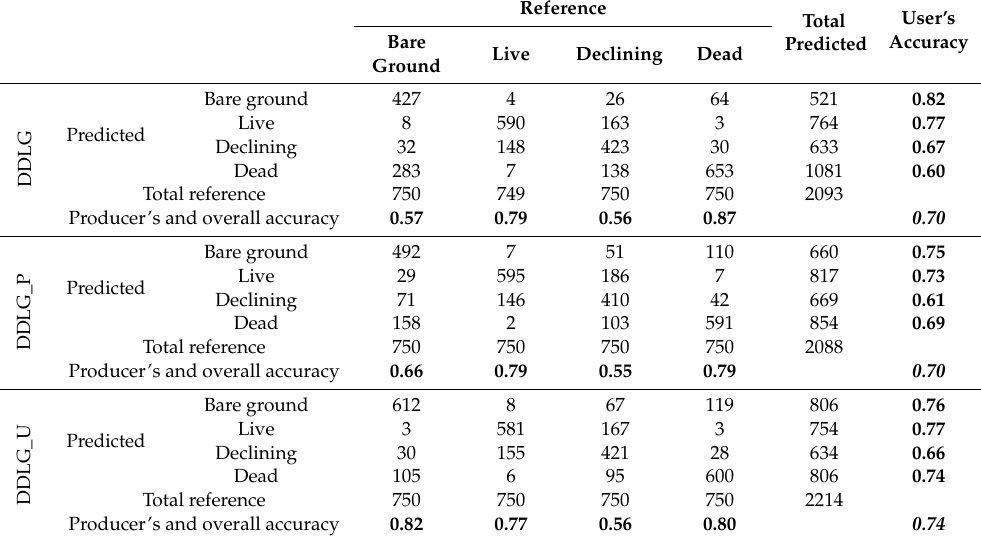
Table A3. Results of the validation of the three deadwood classification models Random Forest (RF) classification (DDLG), RF classification with post-processing (DDLG_P), and after applying a deadwood-uncertainty filter (DDLG_U) based on a stratified random sample (750 pixels per class). Results are presented as confusion matrix, user’s and producer’s accuracy are in bold and overall accuracy in bold / italics.